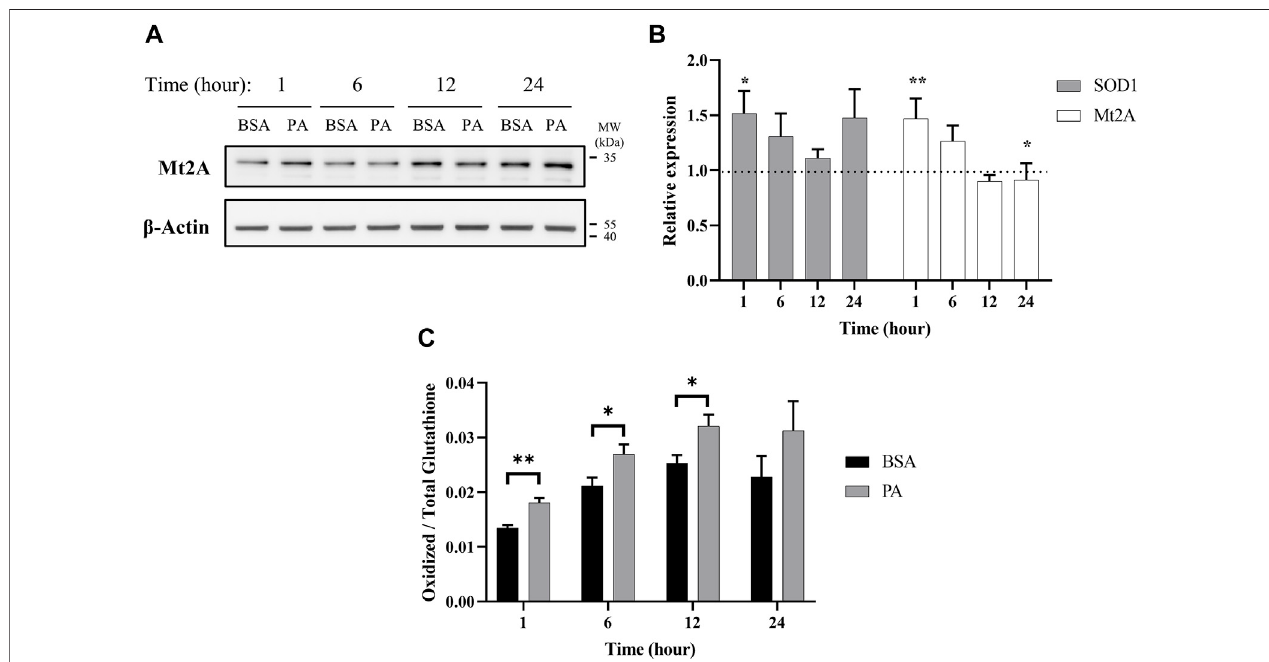
FIGURE 3 | Palmitate stimulations induce changes in cytosolic markers of copper status. Analysis of copper chaperones in the lysates of cells treated with PA or BSA for 1, 6, 12, and 24 h. (A) Representative western blot images of Mt2A. (B) Gene expression analysis of SOD1 ( n = 10) and Mt2A ( n = 10) of PA-stimulated cells relative to BSA-stimulated cells at the same time points (normalized to β -actin as the housekeeping gene). The Mann – Whitney U test was used to assess the statistical signi fi cance. (* p < 0.05 and ** p < 0.01). Mean ± SEM is shown. (C) Ratio of oxidized-to-total glutathione in PA-stimulated cells. The unpaired Student ’ s t -test was used to assess signi fi